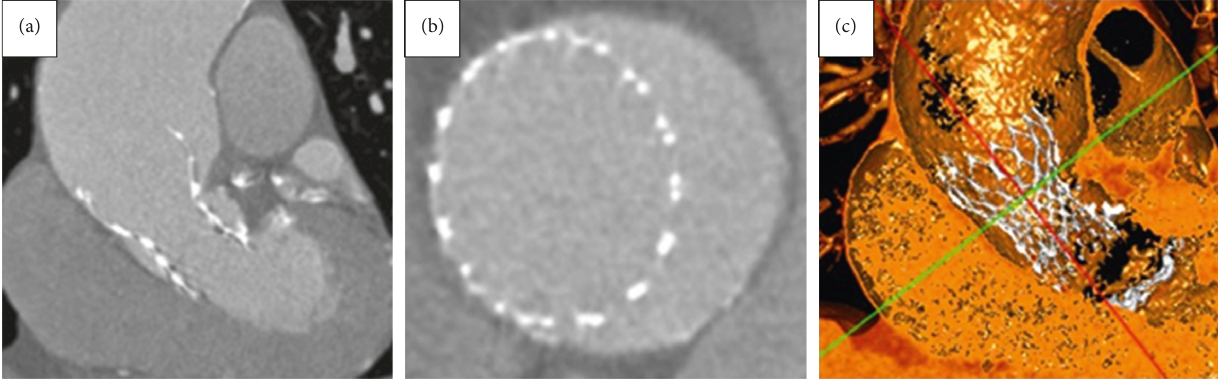
Figure 4: (a) MSCT of the 31mm CoreValve in the aorta postimplant. (b) Aortic end of the CoreValve “floating” in the aorta. (c) 3D reconstruction of the CoreValve showing apposition to the greater curvature of the